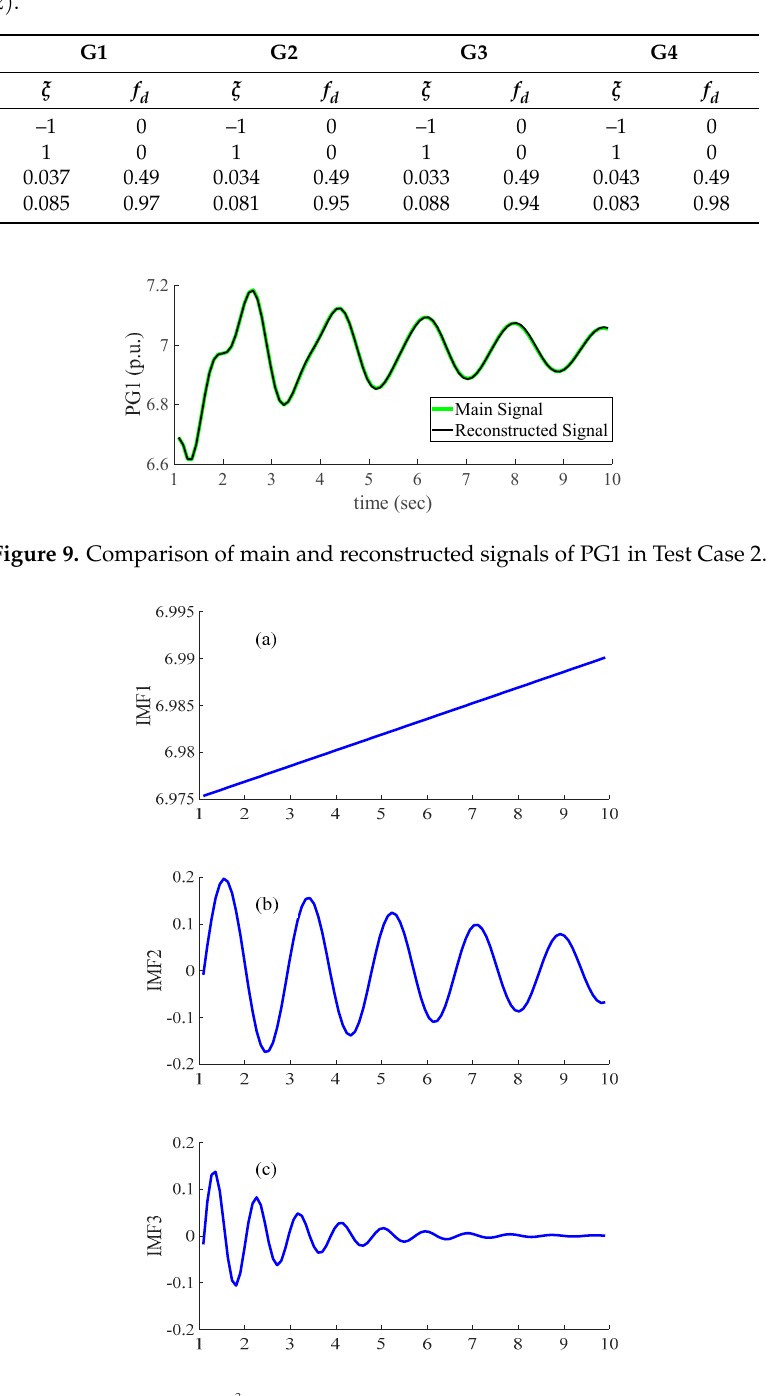
Table 3. Comparison of Extracted Modes based on Active Power of Different Generators in Test Case 2;